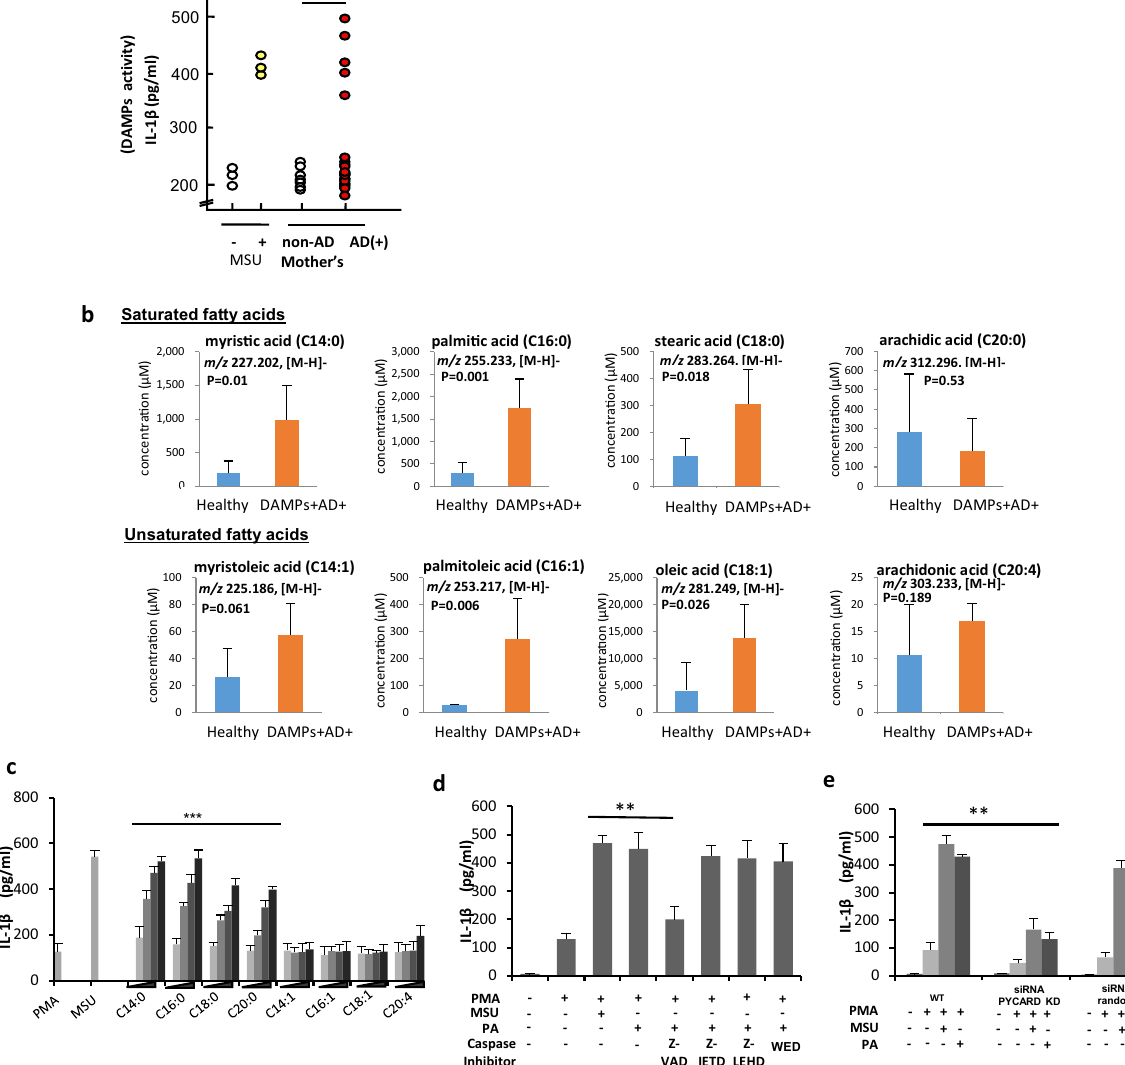
Figure 1. Breastmilk containing high amounts of long-chain saturated fatty acids is associated with atopic dermatitis. ( a ) DAMPs assay. PMA-differentiated THP-1 macrophages were treated with mother’s milk of non-AD or AD(+) infants (n = 75) for 12 h. Monosodium Urate, MSU was used as positive control. IL-1β production in cell culture supernatant was determined by ELISA. ( b ) Quantity of long-chain saturated and unsaturated fatty acids (C14 to C20) in healthy or DAMPs+ AD+ milk was determined by targeted metabolomic analysis (C8 separated). DAMPs+ AD+ milks are samples of AD+ infants and of which their respective mother’s milks are also positive for DAMPs assay. ( c ) DAMPs assay was performed with a series of long-chain saturated (C14:0, myristic acid, C16:0, palmitic acid, C18:0, stearic acid, C20:0, arachidic acid) and unsaturated (C14:1, myristoleic acid, C16:1 palmitoleic acid, C18:1, oleic acid, C20:4, arachidonic acid) fatty acids at an increasing concentration at 50, 100, 150 and 200 μM. ( d ) DAMPs assay of palmitic acid (PA) treated THP-1 macrophages in the presence of caspase inhibitors Z-VAD, Z-IETD, Z-LEHD and wedelolactone, WED. e, DAMPs assay using wild-type, pycard-Asc knockdown or random siRNA knockdown THP-1 macrophages. Results shown are representatives of at least three independent experiments. Data are represented as mean ± SD. * P < 0.05, ** P < 0.01, one-way ANOVA and Student-t test (only in a ). Data are analyzed with Prism8 (version 8.4.3, https:// www. graph pad. com/ scien tific- softw are/ prism